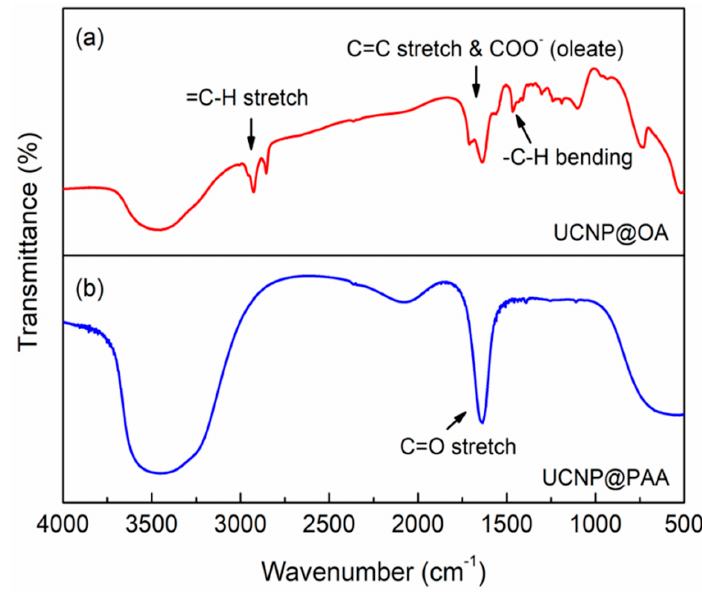
Figure 3. FT-IR spectra of ( a ) UCNPs capped with oleate chains formed during their synthesis and ( b ) UCNP surfaces functionalized by polyacrylic acid (PAA). The spectra were obtained using 16 scans at the resolution of 4 cm − 1 via the KBr technique.